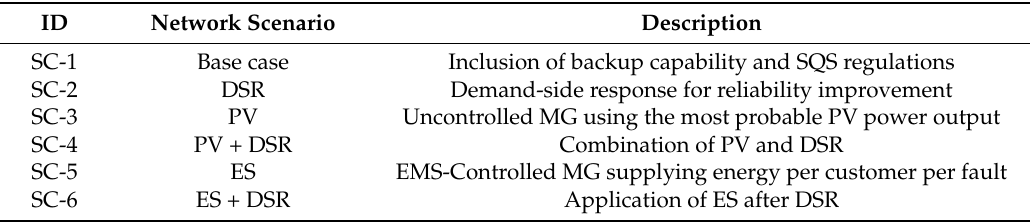
Table 1. Summary of Network